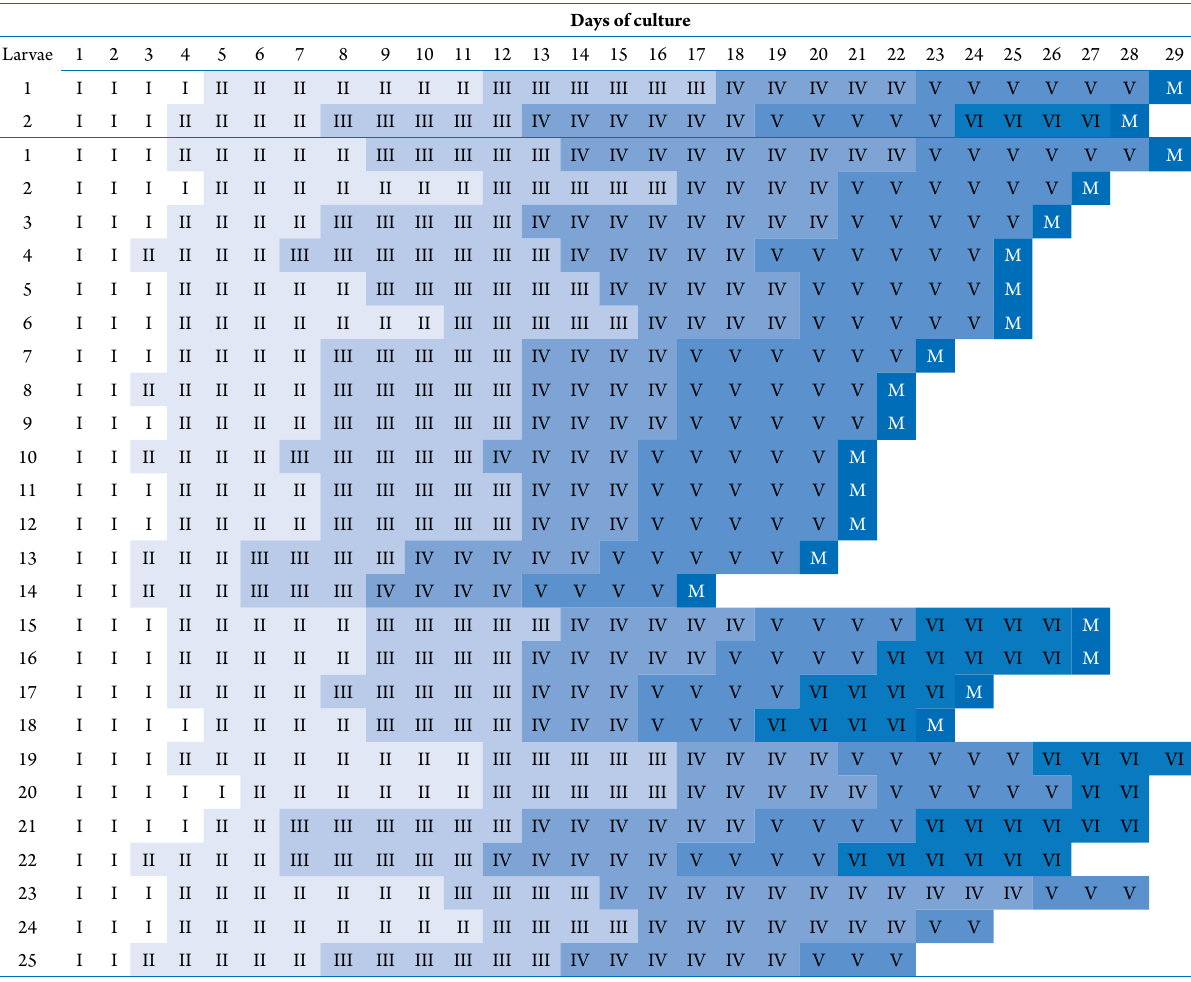
Table 2. Leptuca leptodactyla . Daily individual monitoring of development of all larvae that attained megalopa stage or at least zoea V and zoea VI in the experiments. The first two lines refer to S25 and the remaining to